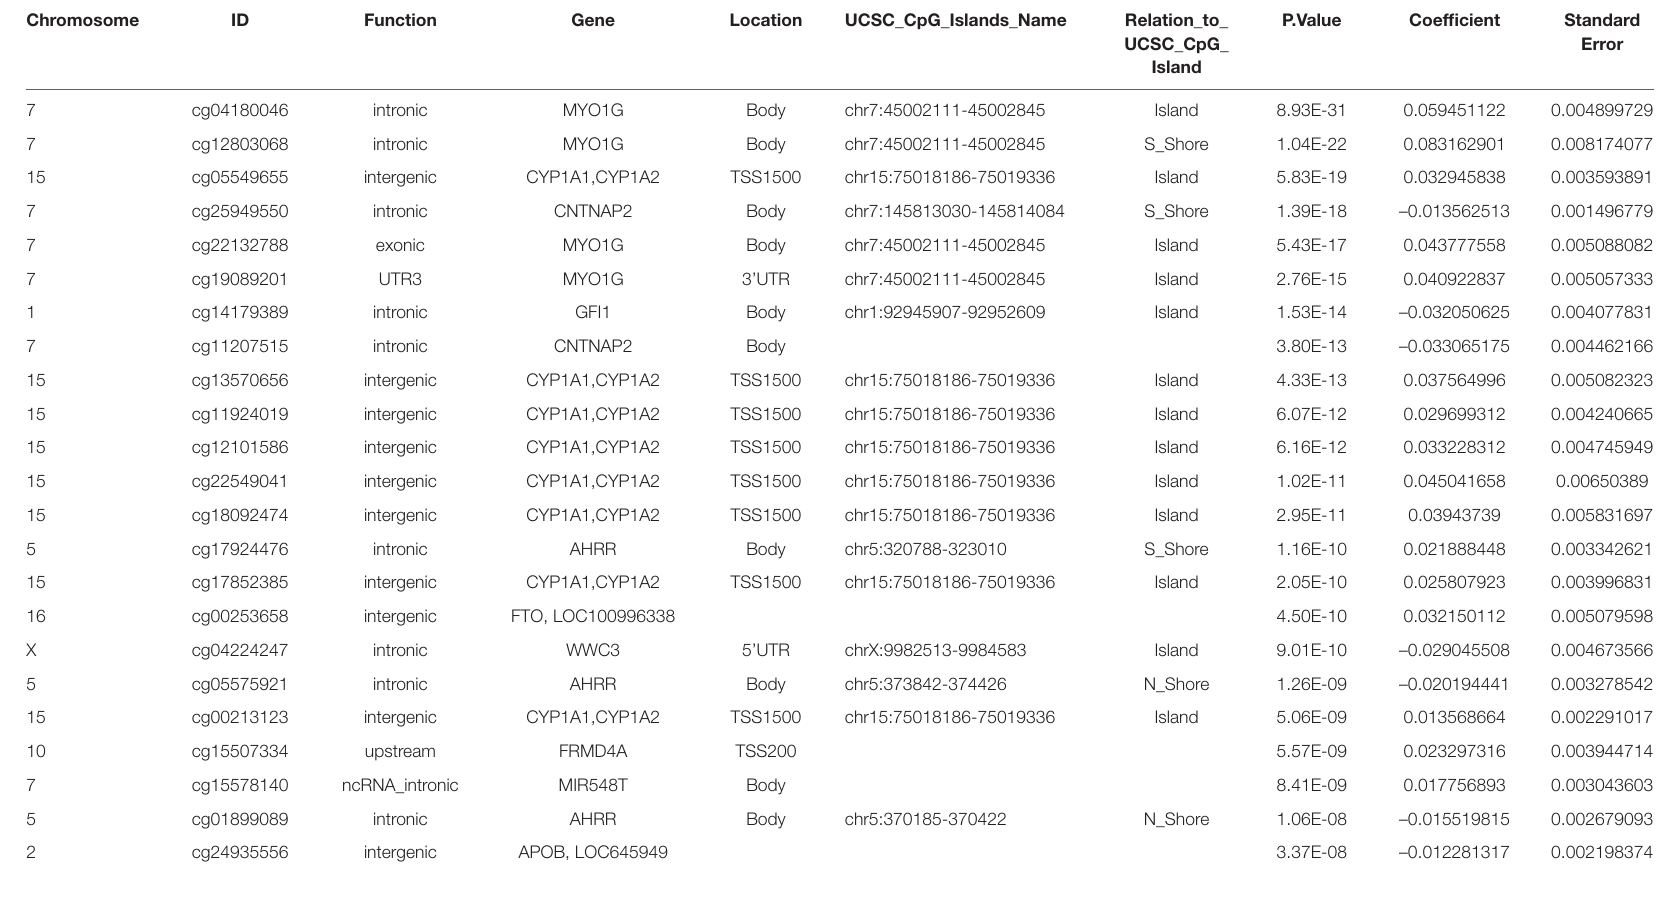
TABLE 2 | CpGs associated with maternal smoking during pregnancy with UCSC gene annotation and model p-values, beta-coefficients and standard errors from the epigenome wide association study. The Bonferroni significance threshold is 1.06 × 10 –7 .